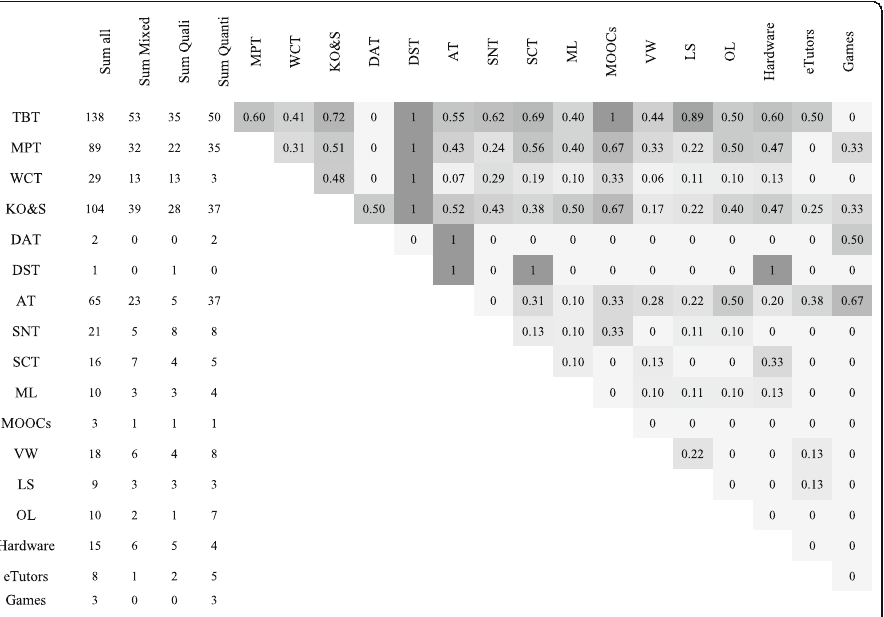
Fig. 7 Co-occurrence of tools across the sample ( n =243). Note. TBT=text-based tools; MPT=multimodal production tools; WCT=website creation tools; KO&S=knowledge organisation and sharing tools; DAT=data analysis tools; DST=digital storytelling tools; AT=assessment tools; SNT=social networking tools; SCT=synchronous